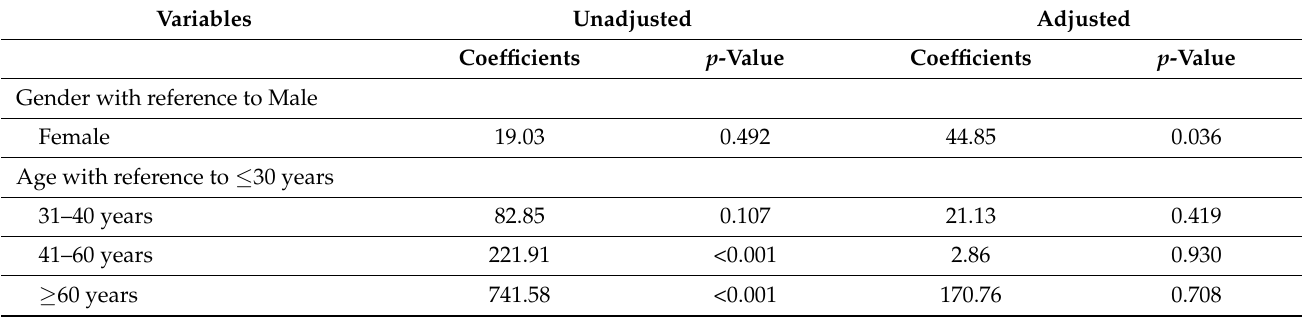
Table 6. Total cost analysis with the median